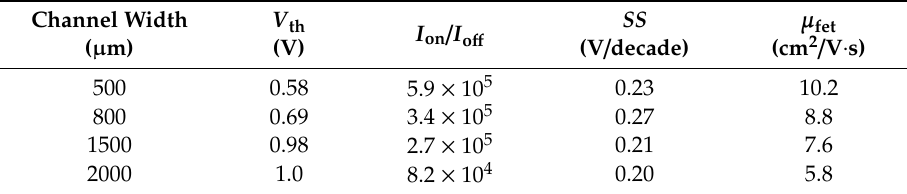
Table 4. The electrical performance parameters of a -IGZO TFT with di ff erent sizes of channel width at an oxygen flow rate of 3 sccm.